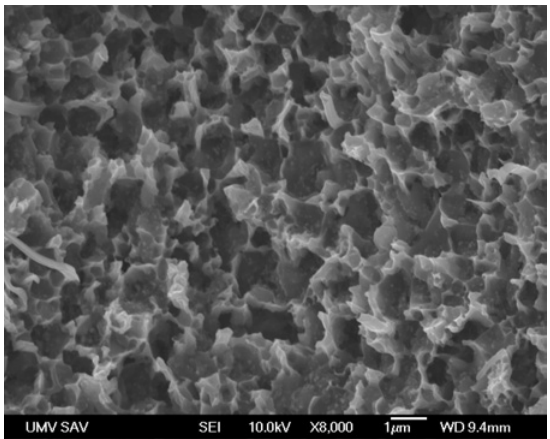
Figure 11. The fracture of Al-4 vol.% Al 4 C 3 after SP creep, direction